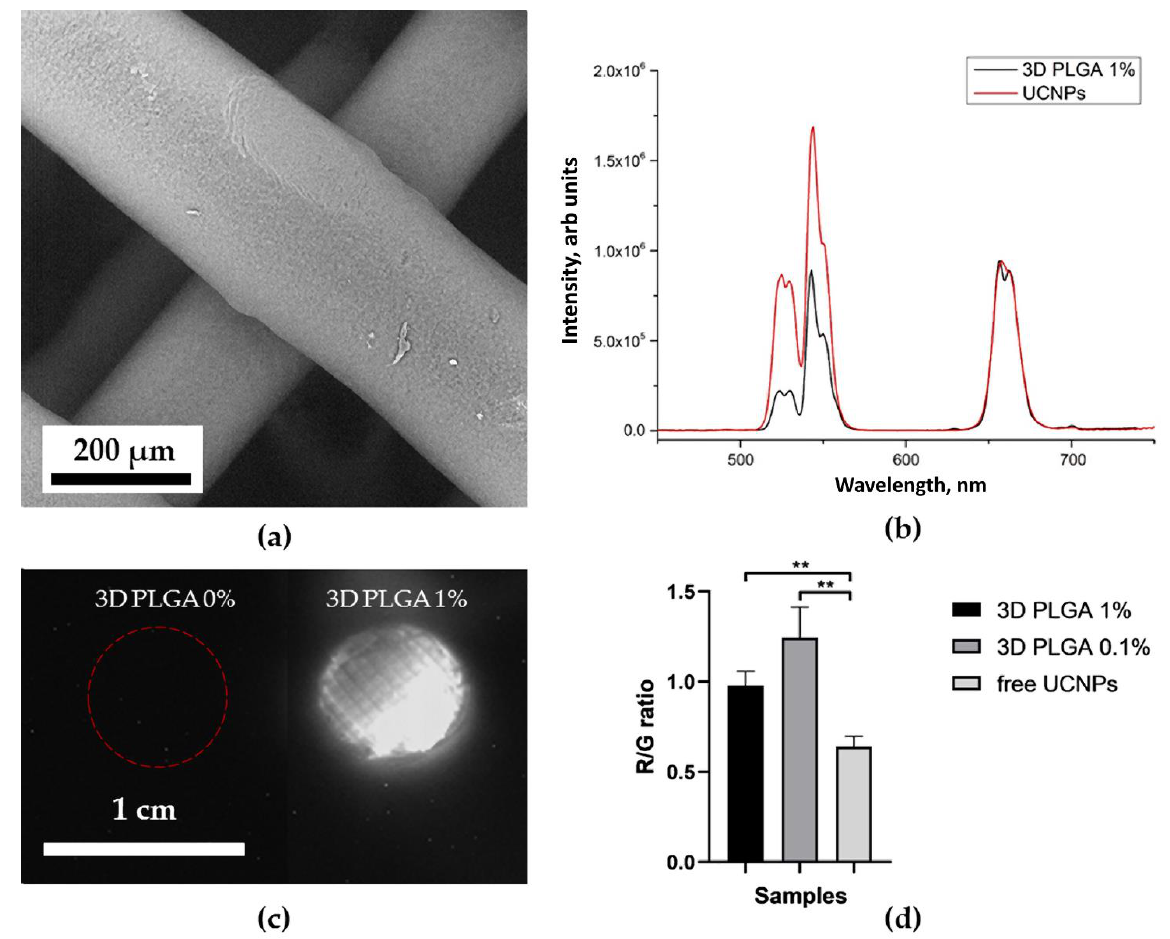
Figure 8. SEM image of 3D-printed polylactic-co-glycolic acids scaffolds ( a ); normalized photoluminescence spectra of the UCNPs and the UCNPs included in 3D PLGA scaffolds ( b ); photograph of 3D PLGA scaffolds with 0 (control) and 1 mg of UCNPs per 100 mg of polymer at 976 nm ( c ). Ratio of the intensity of the red peak at 658 nm to the intensity of the green at a wavelength of 544 nm of UCNPs and 3D PLGA (0.1 and 1% UCNPs) * p < 0.05, ** p < 0.01 in Student ’ s t-test ( d ).